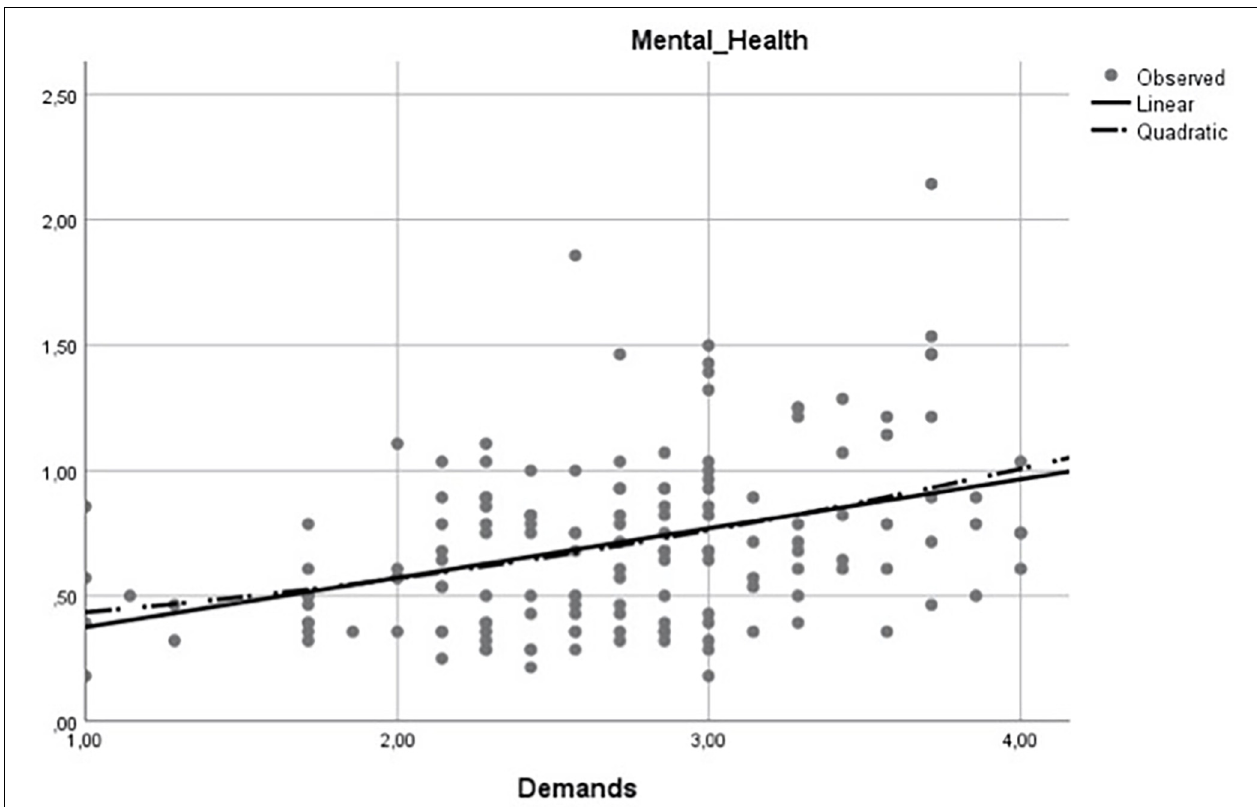
FIGURE 2 | Linear and Curvilinear estimates for